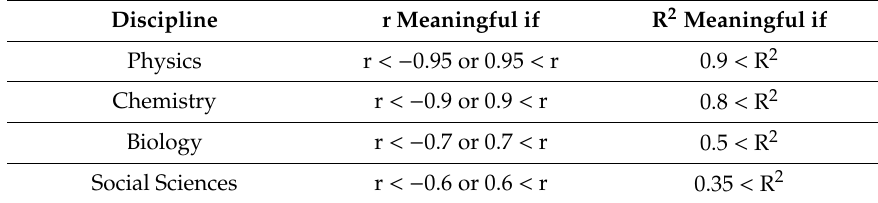
Table 2. Typical variability values for acceptable or good methods for various disciplines (these should be interpreted as typical values; the numbers in the table were taken from http: // condor.depaul.edu / sjost / it223 / documents /